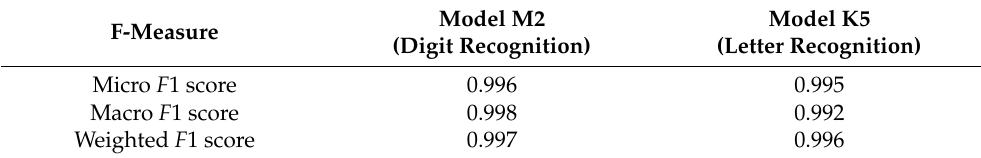
Table 5. Micro, macro, and weighted average of F 1 score for the best two proposed models.